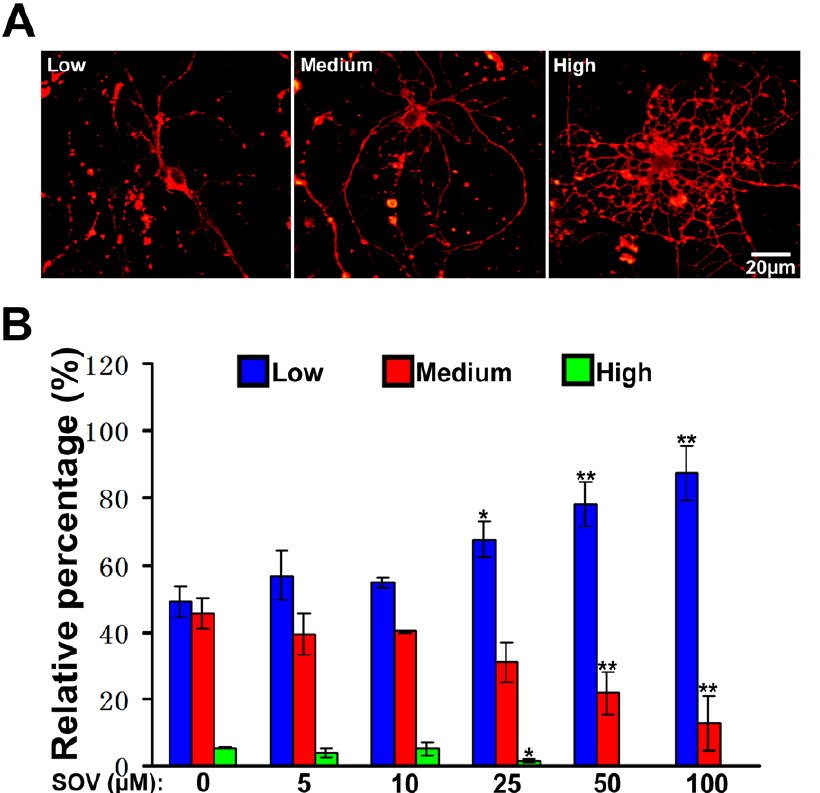
Figure 2. SOV inhibits morphological maturation of OPCs in vitro. ( A ) OPCs were pre-treated with different doses of SOV. After induction of maturation for 1 day, cells were fixed and stained with O4 monoclonal antibody. O4-positive cells were then categorized into three types. The representative images of cells in three categories are shown. ( B ) The percentages of the cells treated with or without SOV in each category were quantified after induction of maturation. For each group, over 1000 cells were analyzed. * P , 0.05, ** P , 0.01 vs controls. Data represent five independent experiments.